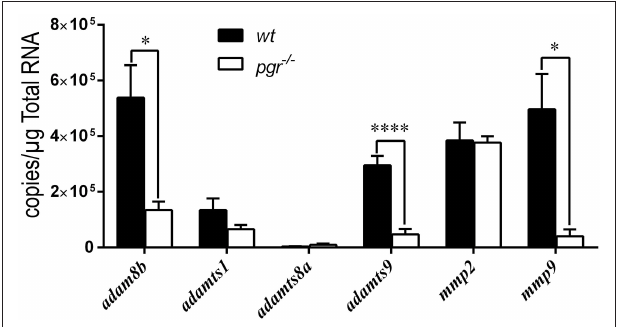
FIGURE 3 | Expressions of adam8b , adamts9, and mmp9 were significantly reduced in the follicular cells of preovulatory follicles (stage IVb) in pgr − / − than those in wildtype ( wt ) in vivo . Transcripts of representative metalloproteinases were determined by quantitative real-time PCR (qPCR) in follicular cells of stage IVb preovulatory follicles (at 08:00) in both wt and pgr − / − . Asterisks indicate significant differences between follicular cells of wt and pgr − / − . * p < 0.05, **** p < 0.0001. N = 6.